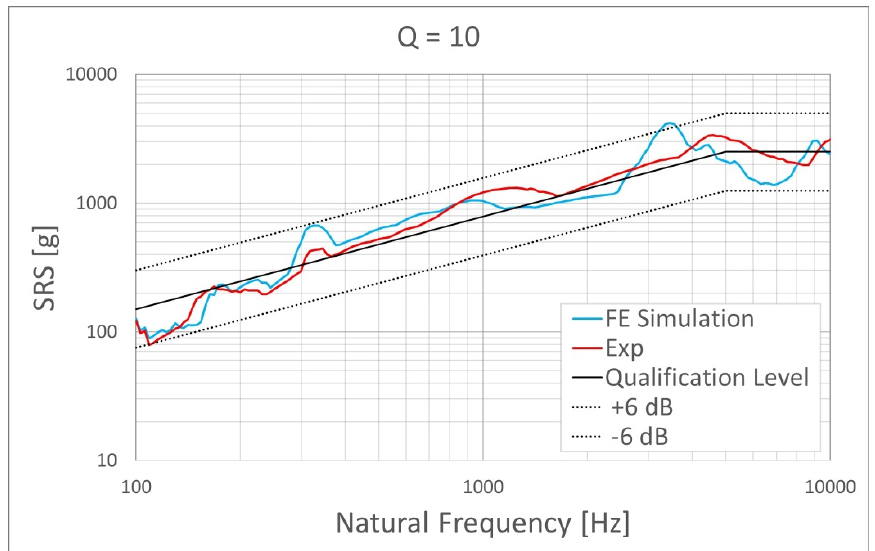
Figure 12. Experimental and numerical SRS results of the test with the dummy instrument.